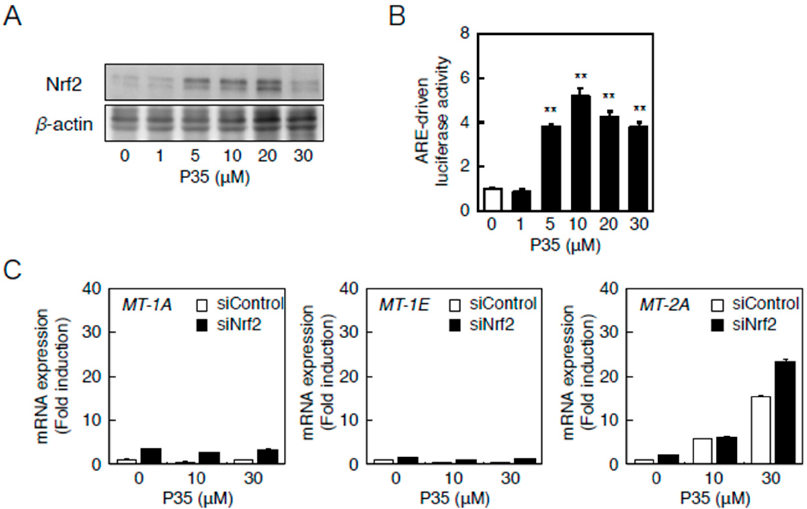
Figure 8. The Nrf2–ARE pathway mediates P35-induced transcription of endothelial MT-2A . ( A , B ) ARE-driven transcriptional activity. Vascular endothelial cells transfected with an ARE reporter vector were treated with or without 1, 5, 10, 20, or 30 µ M P35 for 12 h, and ARE-driven transcriptional activity was determined by performing the ARE-directed reporter assay. Data are expressed as the mean ± SE of three representative samples, with each sample obtained from three independent experiments. ** p < 0.01 indicates significantly different from the corresponding control; ( C ) P35-induced transcription of endothelial MT-1A , MT-1E , and MT-2A after Nrf2 knockdown. Vascular endothelial cells transfected with control or Nrf2 siRNA were treated with or without 10 or 30 µ M P35 for 12 h. Data are expressed as the mean ± SE of three representative samples, with each sample obtained from three independent experiments. ** p < 0.01 indicates significantly different from the corresponding siControl.